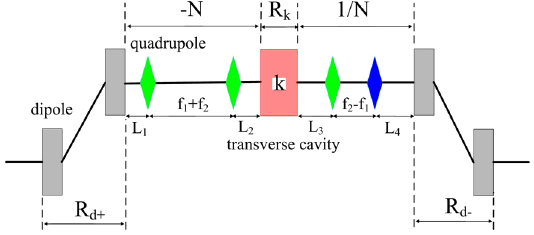
FIG. 3. Exact EEX beam line with j (cid:2)k j < 1